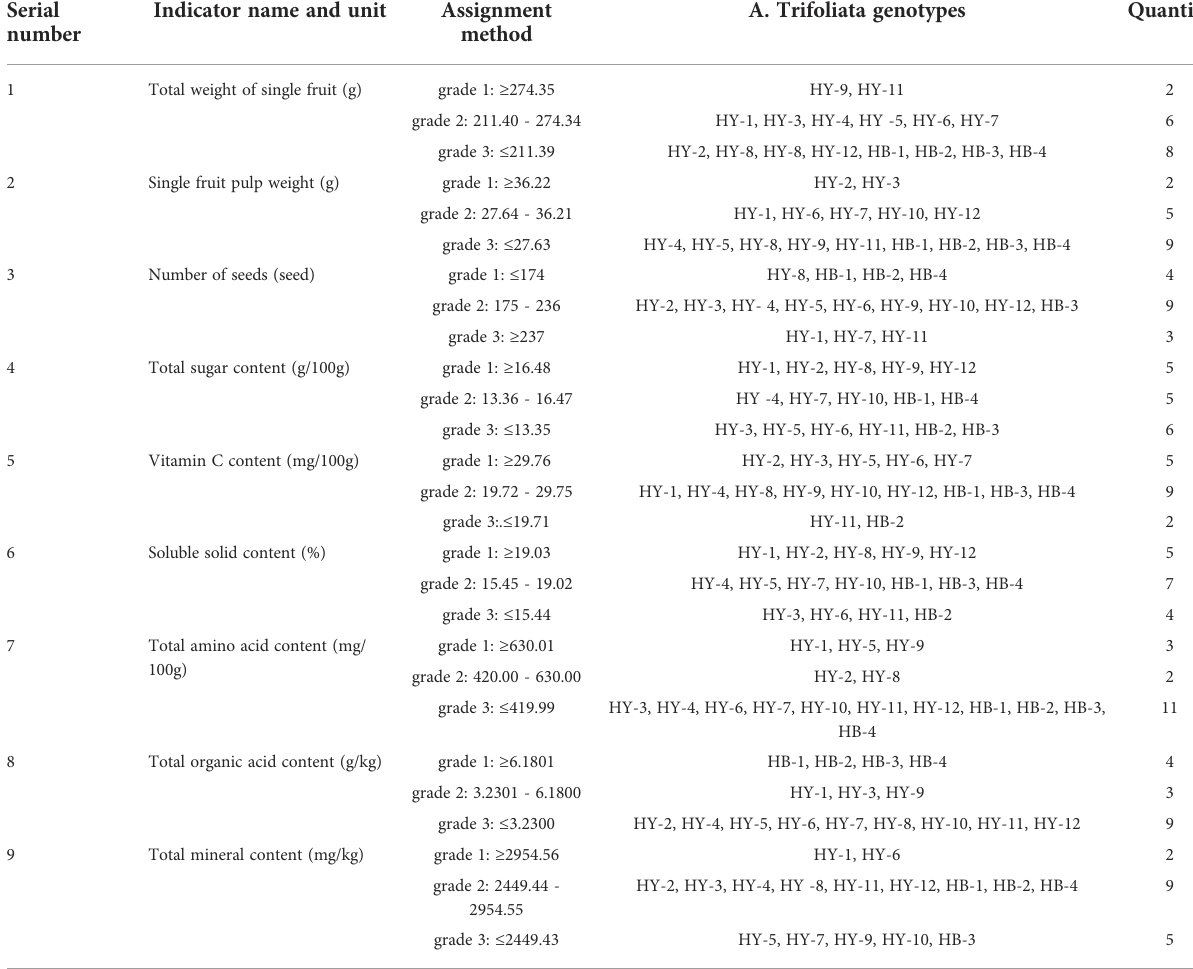
TABLE 11 Results of clustering analysis of 16 A . trifoliata genotypes with 9 quality indicators (3